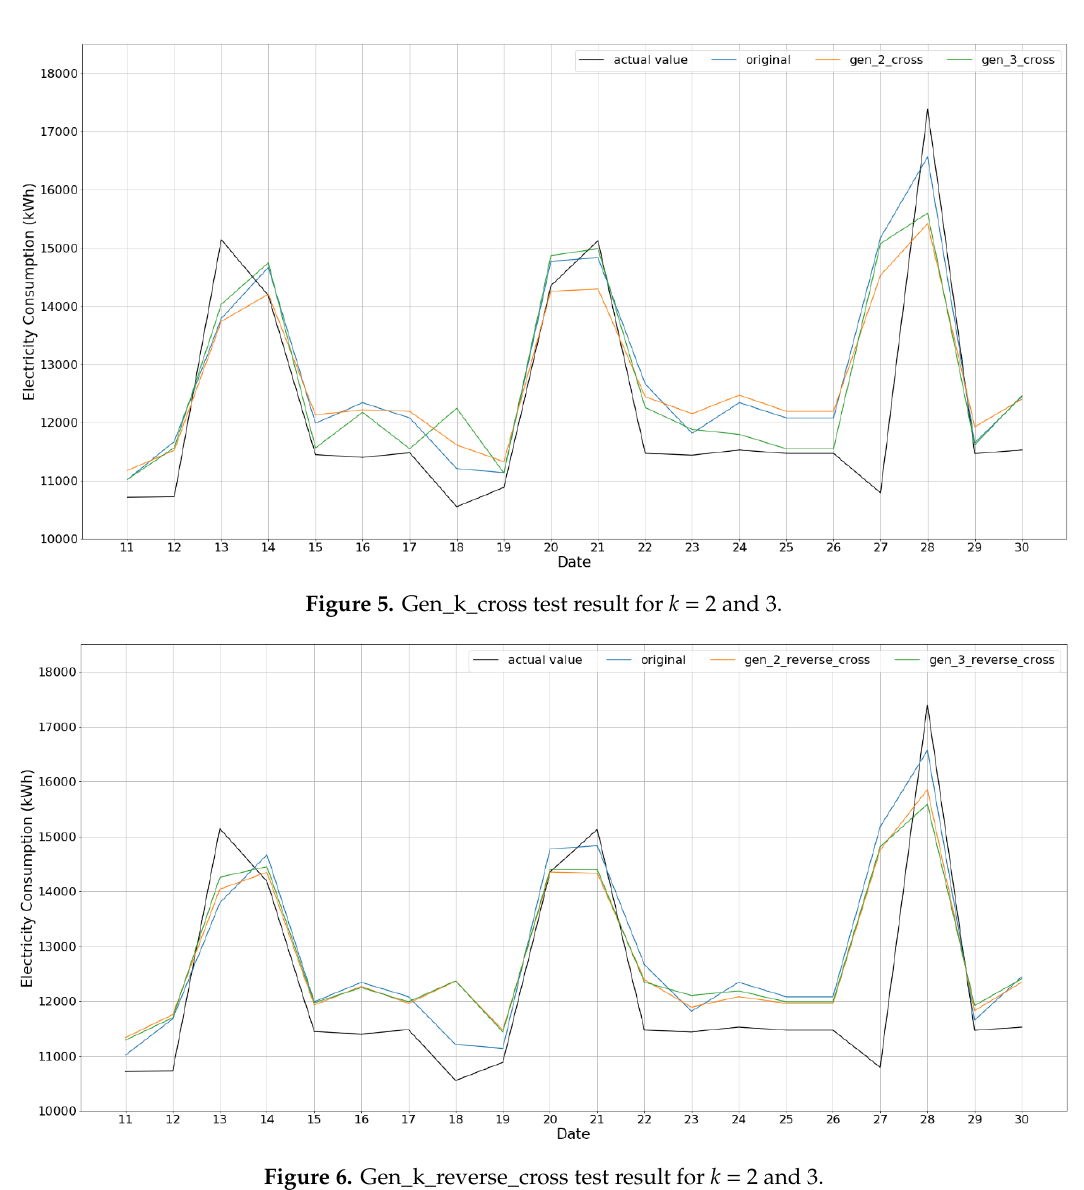
Figure 6. Gen_k_reverse_cross test result for k = 2 and 3.